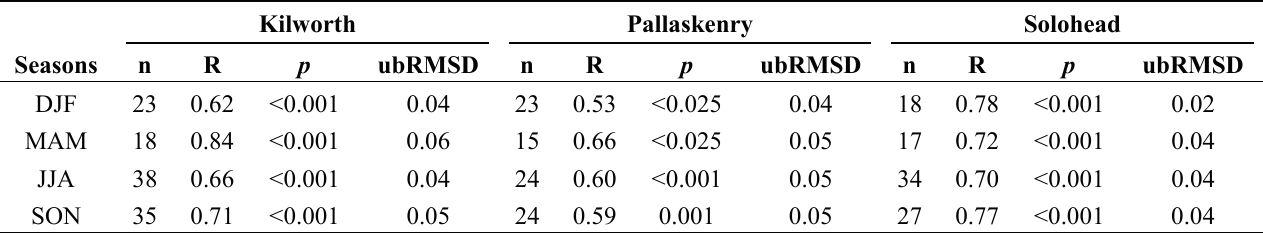
Table 7. Seasonal correlation (R) and unbiased RMSD (ubRMSD) between ASAR and ECV SM datasets (winter: DJF; spring: MAM; summer: JJA; autumn: SON). The